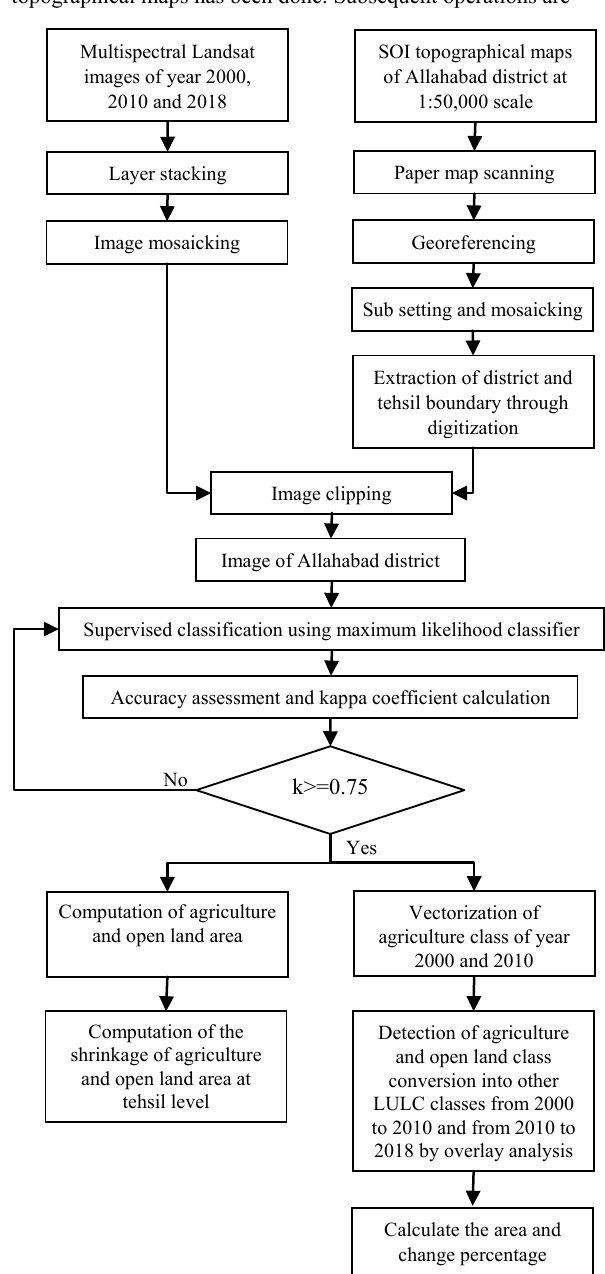
Figure 2. Flowchart of